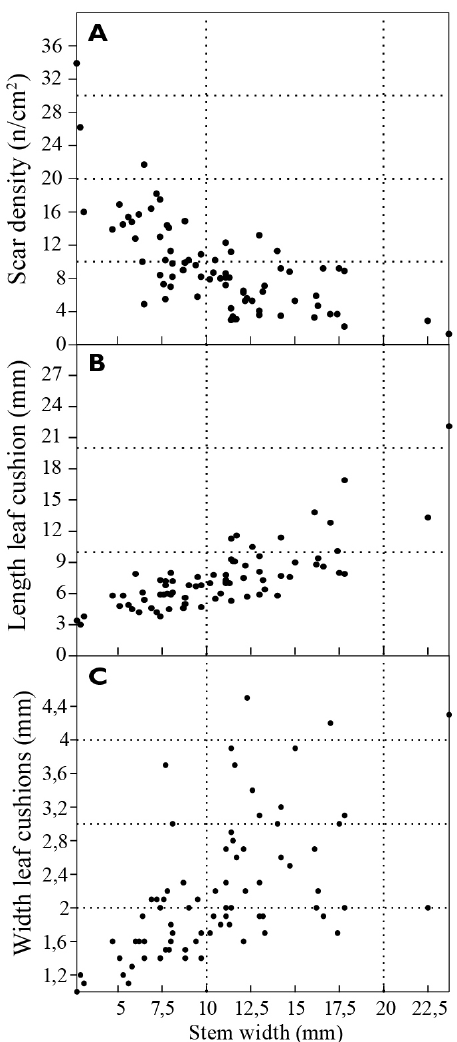
Figure 5. Changing properties with changing stem width: A Diagram of the scar density (in n/cm 2 ) to the stem width (in mm) B Diagram of leaf cushion length (in mm) to stem width (in mm) C Diagram of leaf cushion width (in mm) to stem width (in